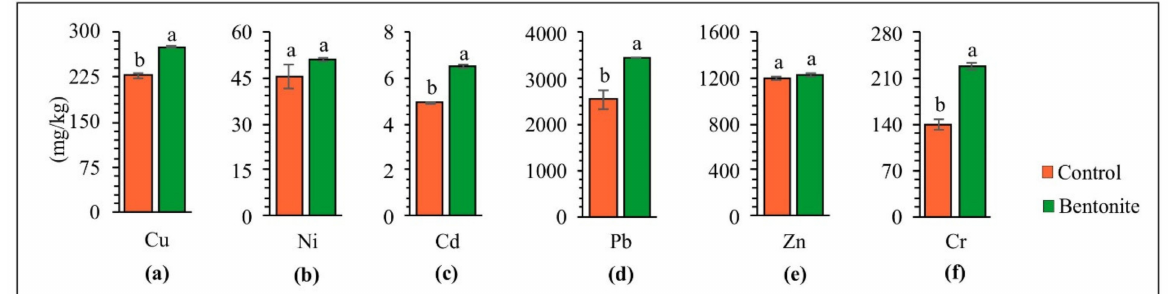
Figure 4. Content of copper ( a ), nickel ( b ), cadmium ( c ), lead ( d ), zinc ( e ), and chromium ( f ) in roots of tested plants. Different letters indicate significant differences ( p < 0.05) between the control and bentonite